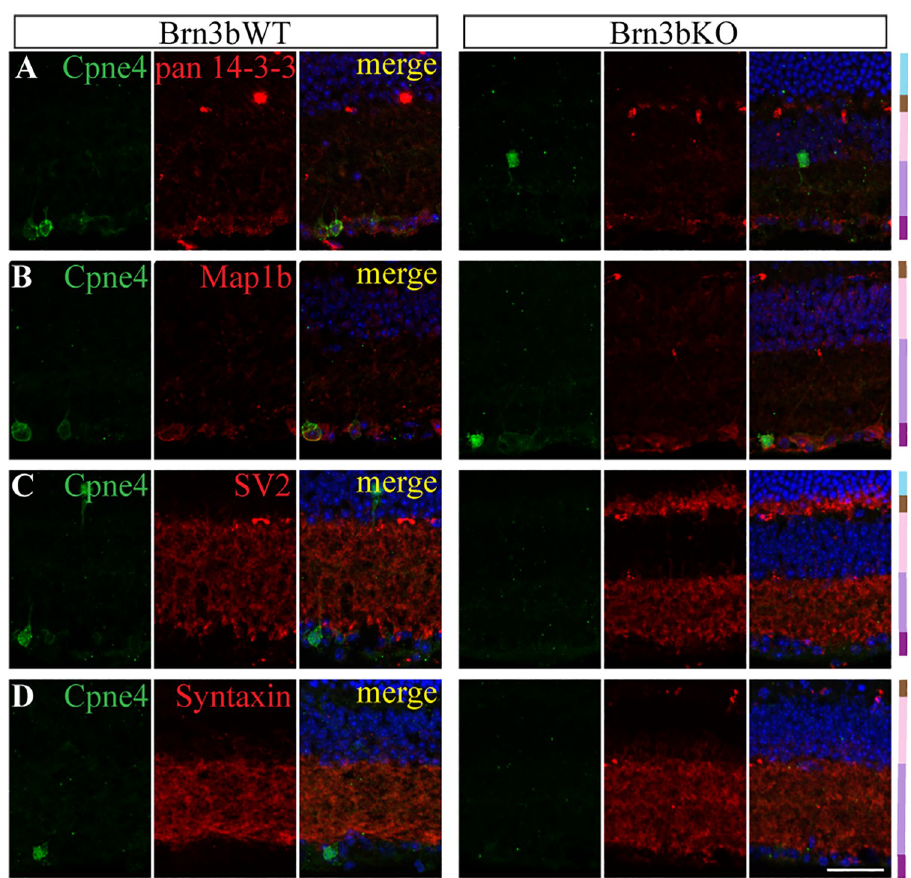
Fig 7. Immunostaining of LC-MS interactors with Cpne4 in retina. Representative images showing immunostaining of pan 14-3-3 (A); Map1b (B); SV2 (C) and Syntaxin (D; red ) with Brn3b ( green ) in Brn3b WT (left panel) and KO (right panel). Retinal layer color codes: ONL- light blue , OPL- brown , INL- pink , IPL- purple , GCL- magenta . Scale bar: 50 μ m.